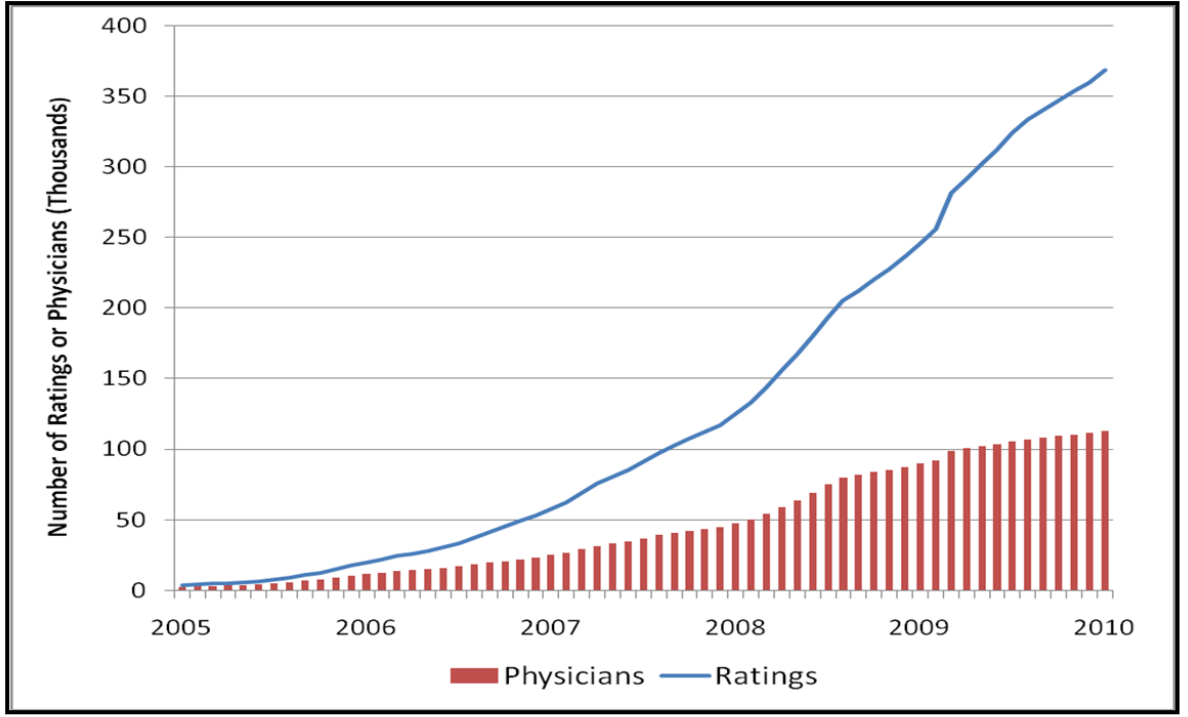
Figure 1. Cumulative number of ratings and rated physicians (based on data from